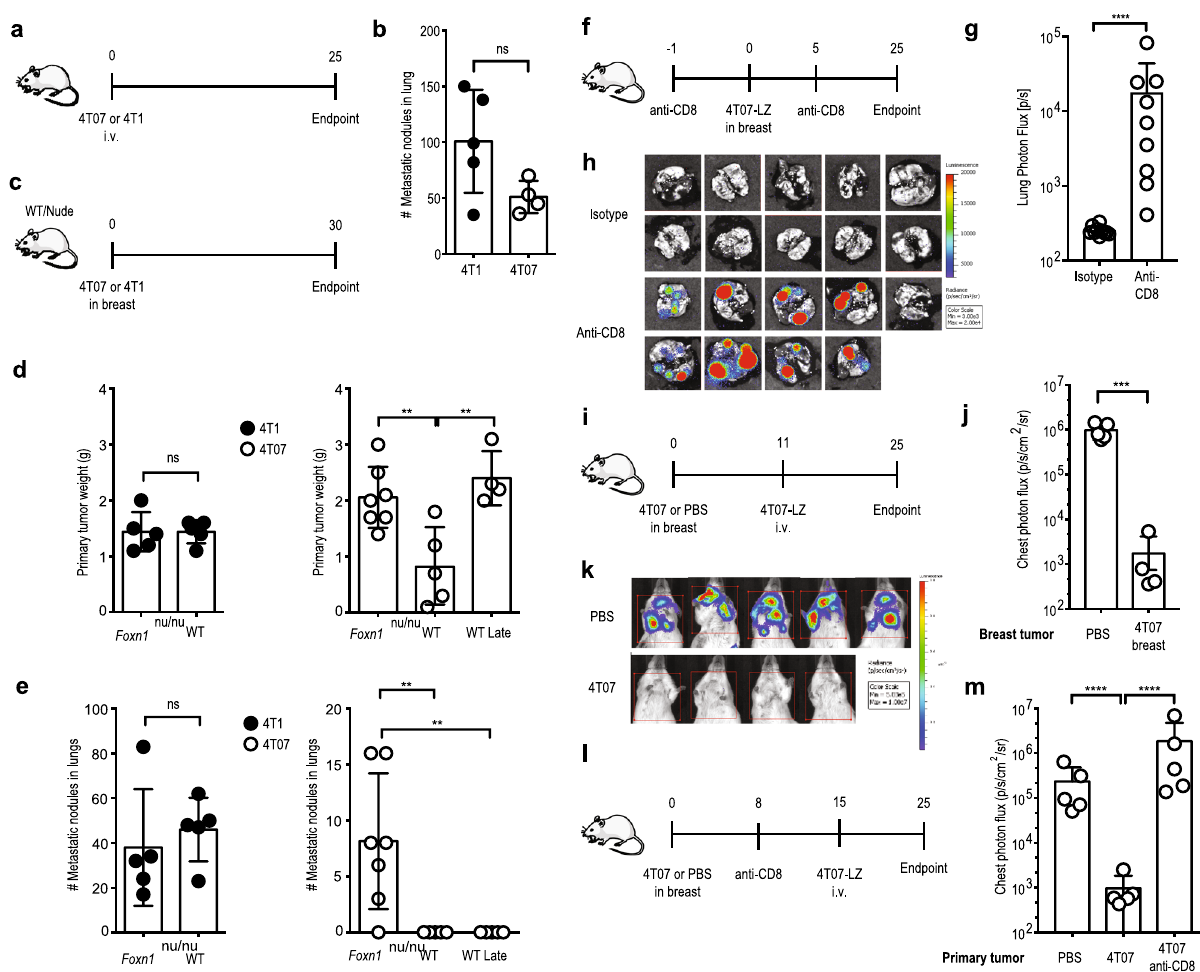
Fig. 2 Induction of protective immunity by the primary tumor mediates metastatic dormancy. a Experimental design. 4T1 or 4T07 cells (3 × 10 5 ) were injected i.v. into female BALB/c mice. Analysis 25 d later. b Number of lung metastatic nodules. 4T1, n = 5; 4T07, n = 4. c Experimental design. 4T1 or 4T07 cells (10 5 ) were injected into the mammary fat pad of female BALB/c or BALB/c Foxn1 nu/nu mice. Analysis 30 d later. Lungs of “ WT Late ” mice were analyzed when the 4T07 tumor size reached the size of the BALB/c Foxn1 nu/nu group (d 35). d Weight of primary tumors. Left panel with closed symbols, 4T1. Both groups n = 5. Right panel with open symbols, 4T07. Foxn1 nu/nu , n = 7; WT, n = 5; WT late, n = 4, ** p = 0.006 ( Foxn1 nu/nu vs. WT), ** p =